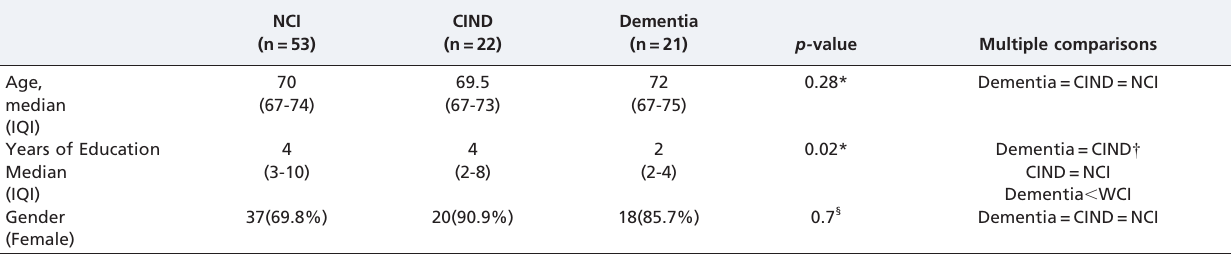
Table 1 - Age, education level and gender of the subjects with and without cognitive impairment.